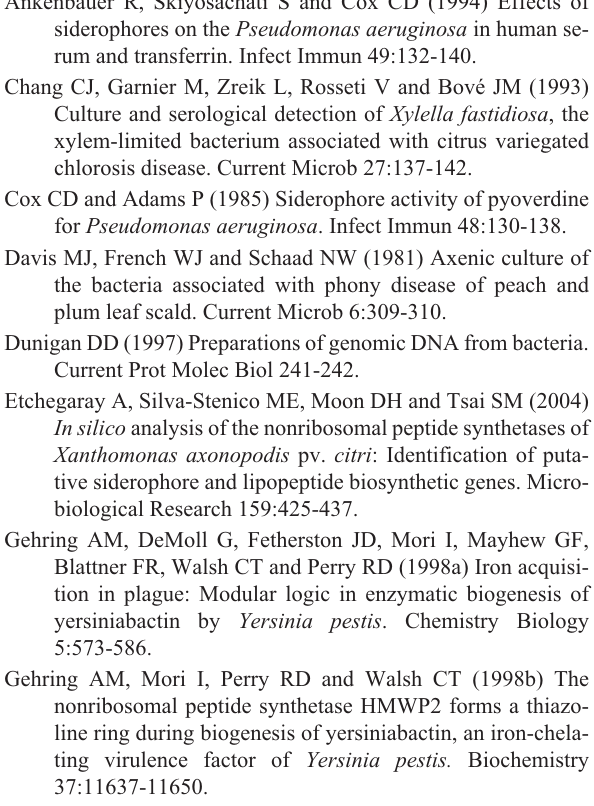
Number of isolates